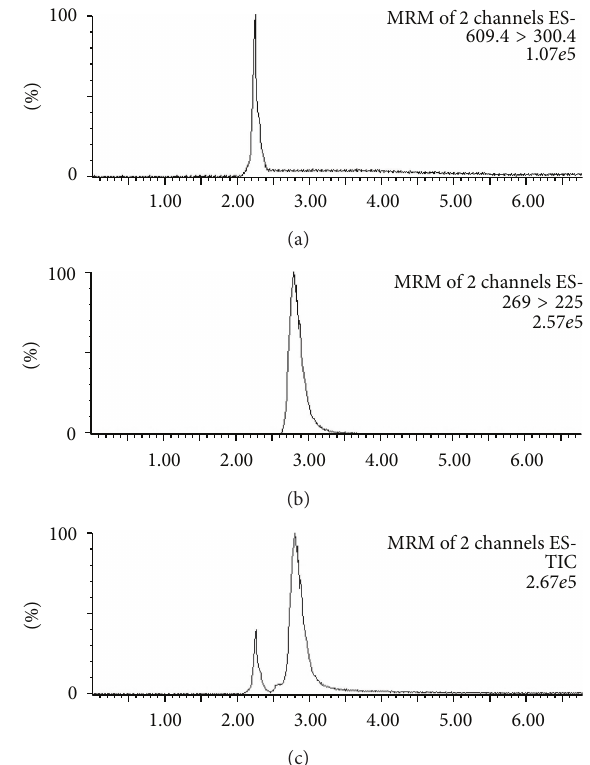
Figure2:Multiplereactionmonitoringchromatogramsofrutinand the internal standard. The retention times were 2.25 and 2.85 min for rutin and IS (emodin), respectively, using reverse-phase HPLC with a mobile phase consisting of 0.1% acetic acid/acetonitrile (20:80, v/v). (a) Chromatogram for rutin; (b) chromatogram for emodin; (c) chromatogram for both rutin and emodin.